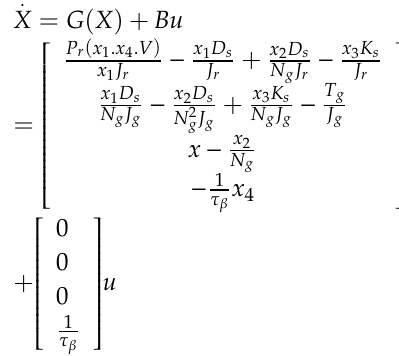
Figure 3. Curves of power coe ffi cient C P ( λ . β )